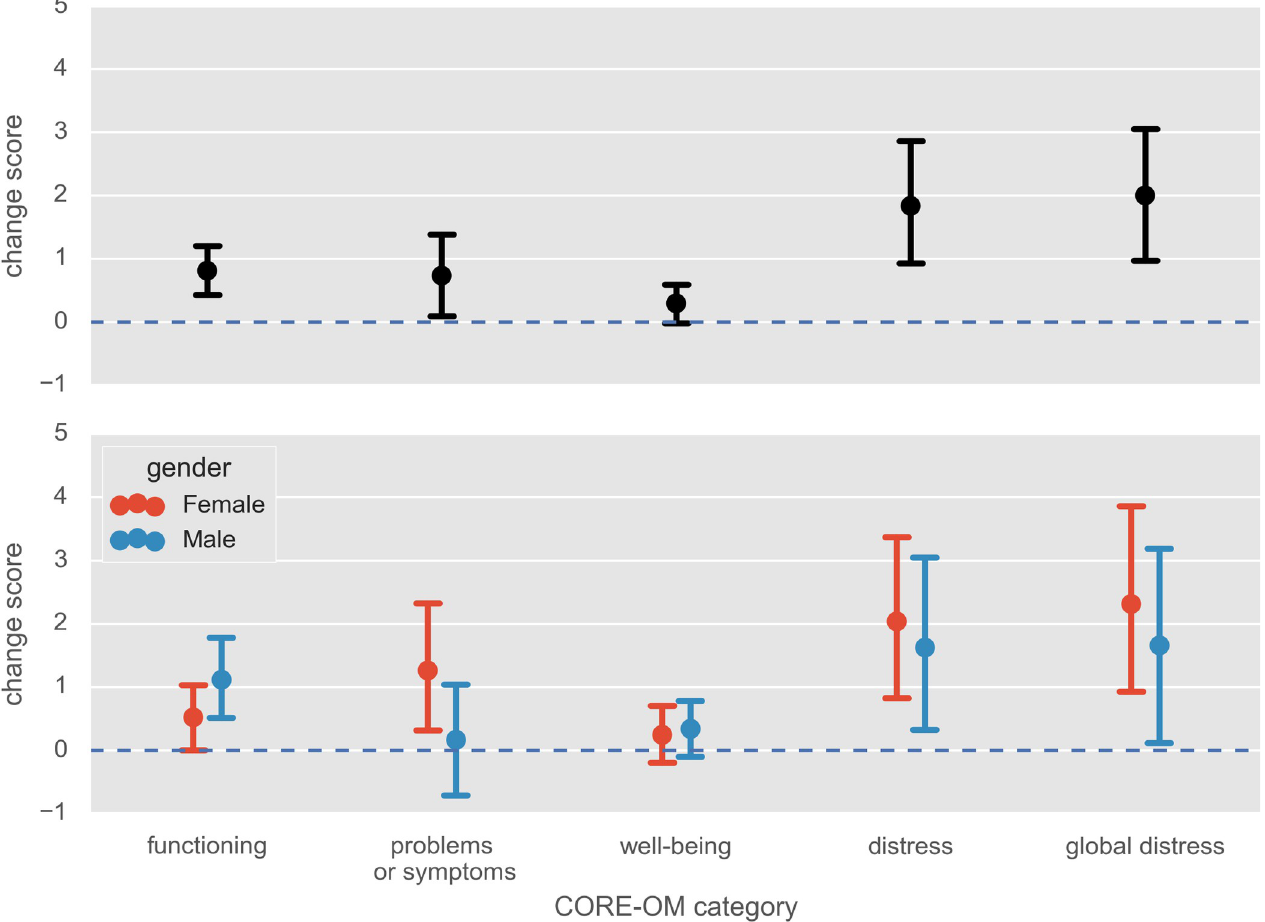
Fig 2. Change scores for dependent variables. Horizontal line at zero indicates no change. Plots represent Mean +/- 2 � S.E.